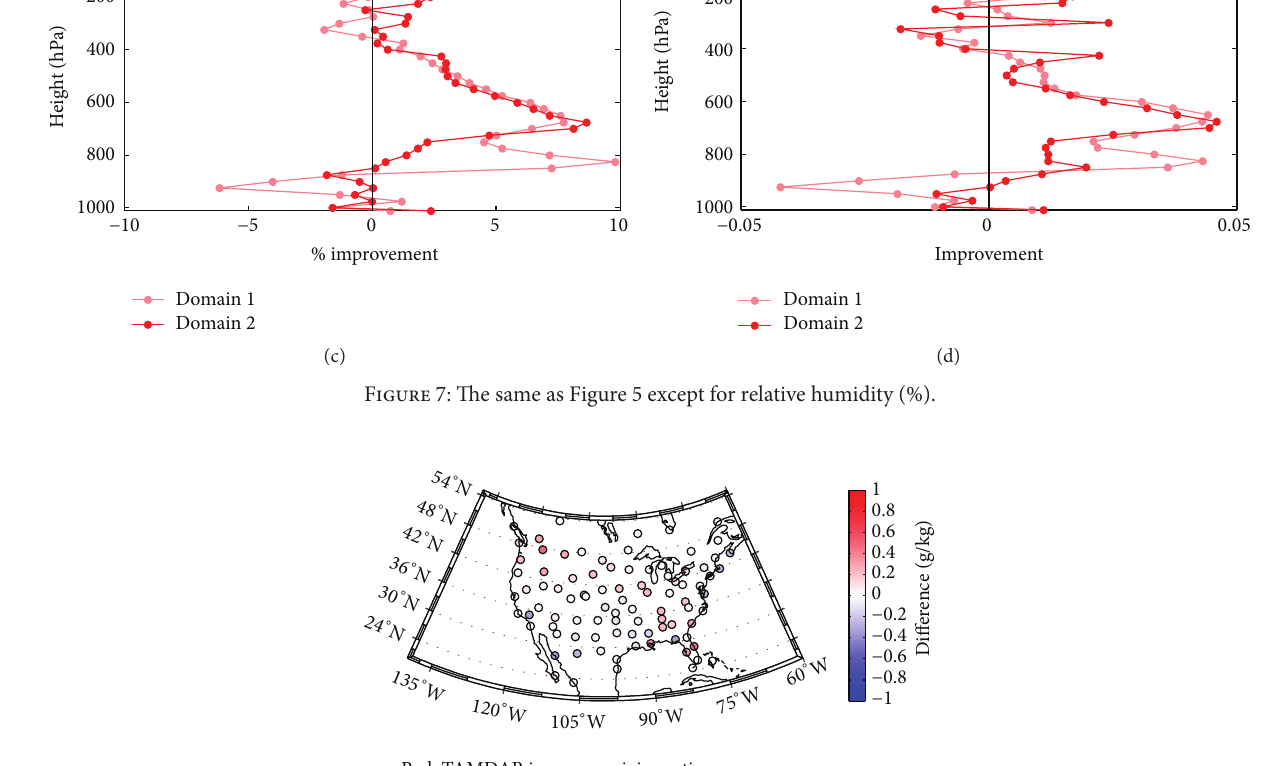
Figure 8: Spatial patterns of the mixing ratio differences (gkg −1 ) for Domain 1 between the runs with and without assimilating the TAMDAR data. The differences are averaged over the 500 to 850 hPa layer and over the 6-day simulation period. Red colors indicate an increase in mixing ratio by assimilating the TAMDAR data while blue colors indicate a